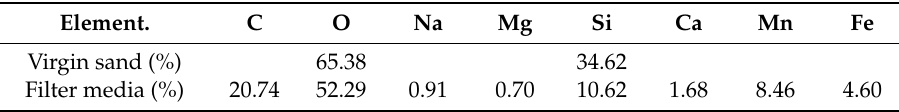
Table 3. The elemental composition of the virgin sand and the filter media.